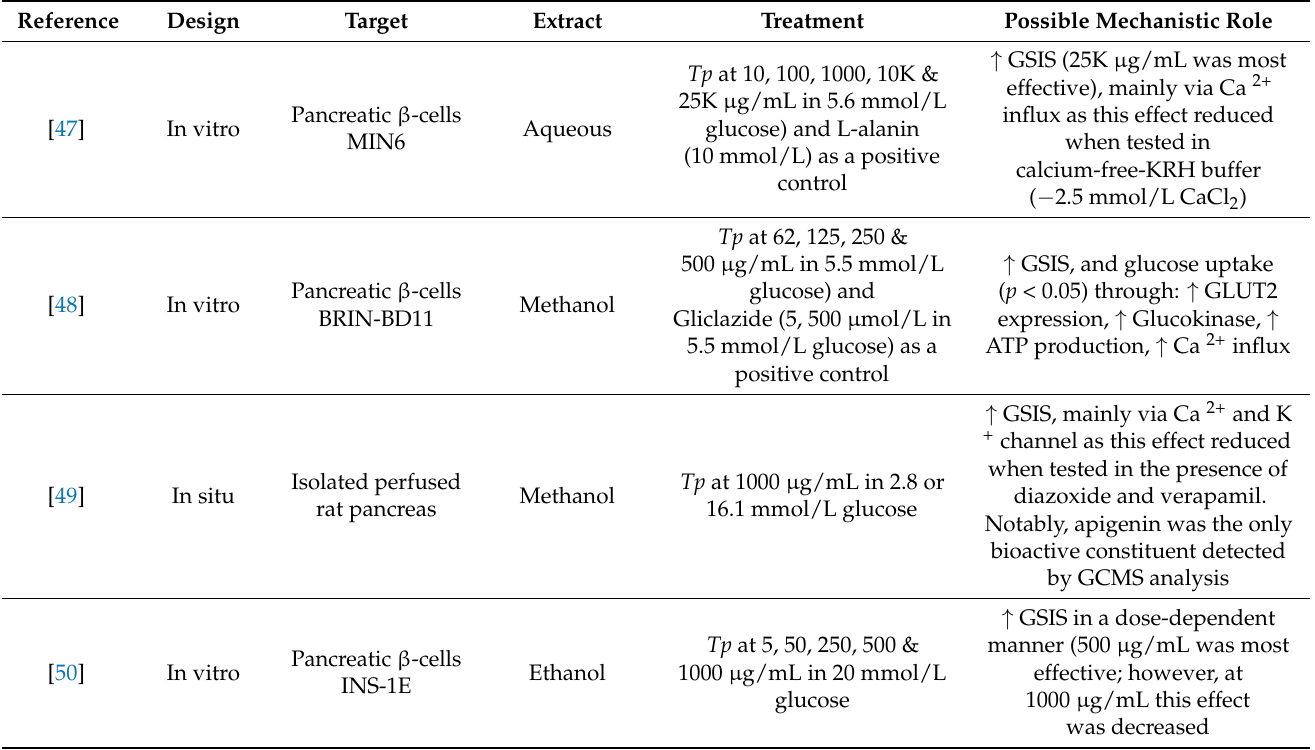
Table 2. Studies on the insulinotropic effect of Tp on pancreatic